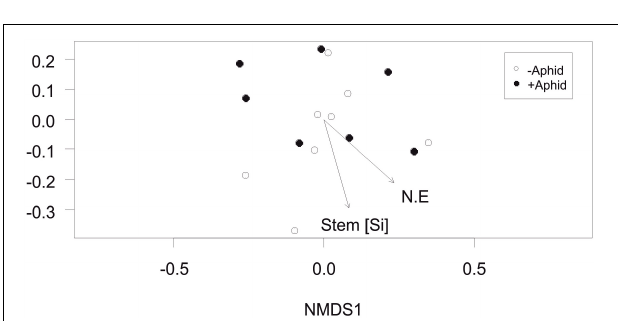
FIGURE 3 | Total fungi community composition: Non-Metric Multidimensional Scaling (NMDS) of total fungi community distribution based on Bray-Curtis dissimilarity (stress = 0.158) obtained from the abundance of “total fungi amplicon” OTUs under “+Aphid,” or “–Aphid” treatments. Total fungi community composition was significantly associated with the grain P concentration (mg g - 1 ) in the plots (Grain [P]) and the location of the plot in the NE direction of the site (NE).